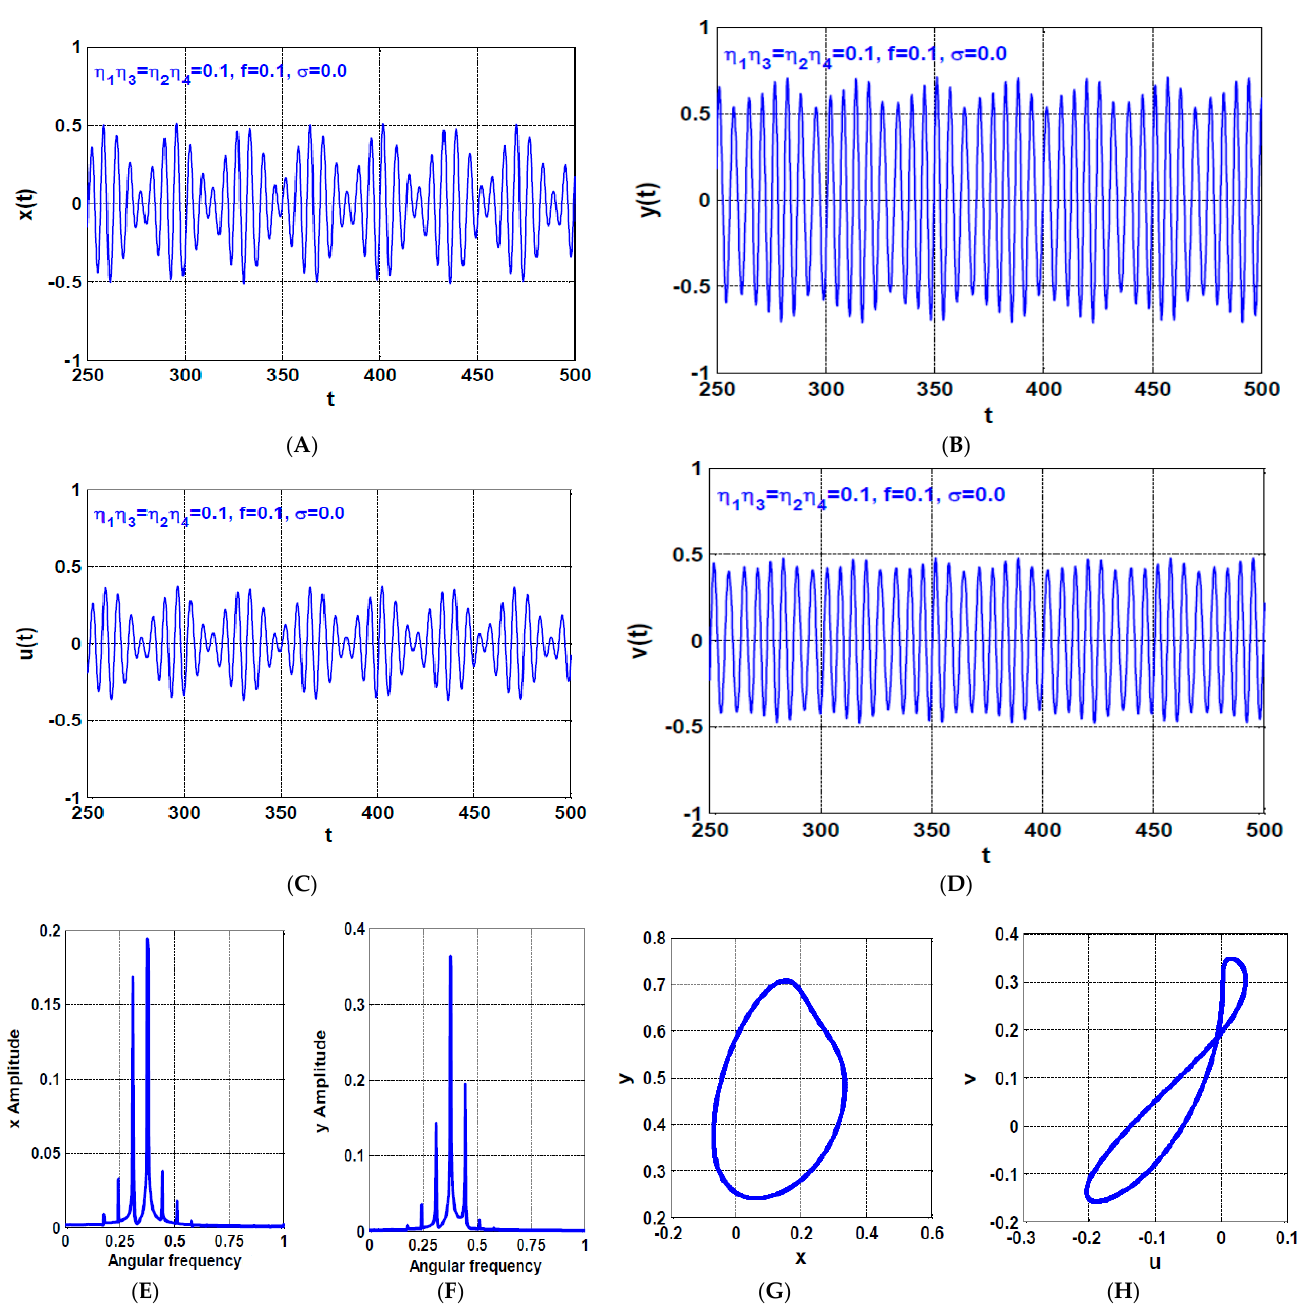
Figure 22. The rotor system steady-state time-response according to the point p 1 shown in Figure 21B (i.e., when σ = 0.0, η 1 η 3 = η 2 η 4 = 0.1): ( A , B ) temporal oscillation in X and Y directions, respectively, ( C , D ) temporal oscillations of the U-IRC and V-IRC, respectively, ( E , F ) frequency spectrum, ( G , H ) the corresponding Poincaré map.